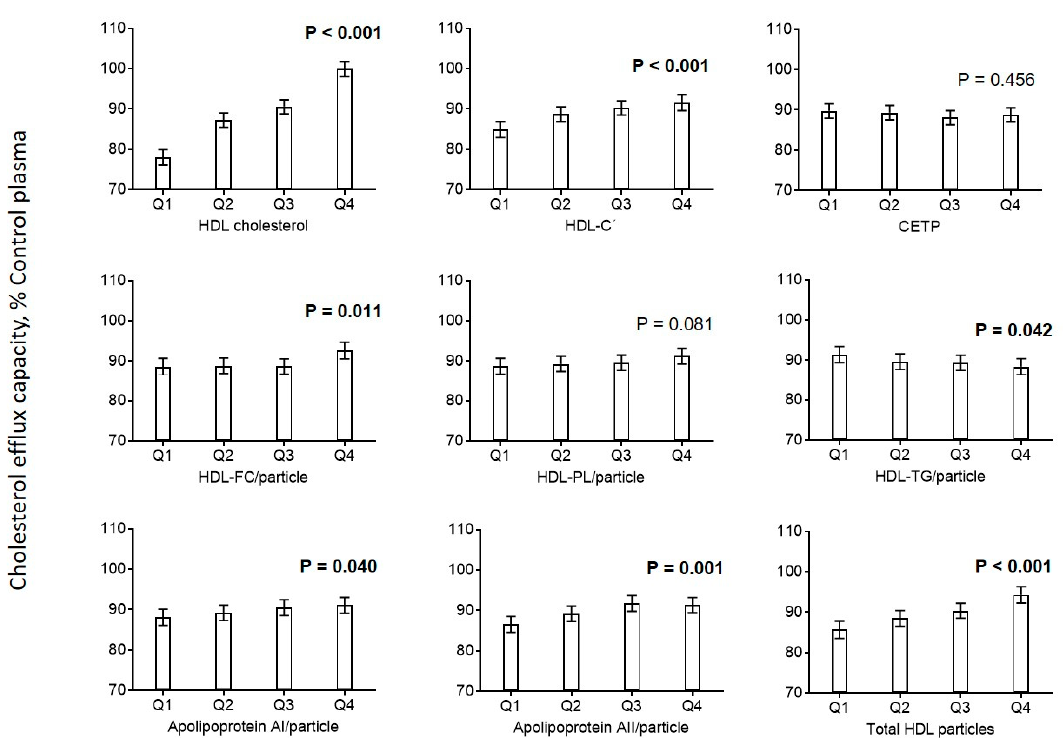
Figure 2. Association of HDL parameters with cholesterol efflux. Diagrams show estimated marginal means with 95% confidence intervals obtained from a general linear model adjusted for use of statins, age, CAD, diabetes mellitus, smoking, LDL cholesterol, HDL cholesterol, and triglycerides. Age, LDL cholesterol, HDL cholesterol, and triglycerides (log-transformed) were included as continuous rather than categorical covariables. p values are given for comparison with the first category of each variable. p values < 0.05 are shown in bold. Biologically effective HDL cholesterol (HDL-C ˡ ) was calculated